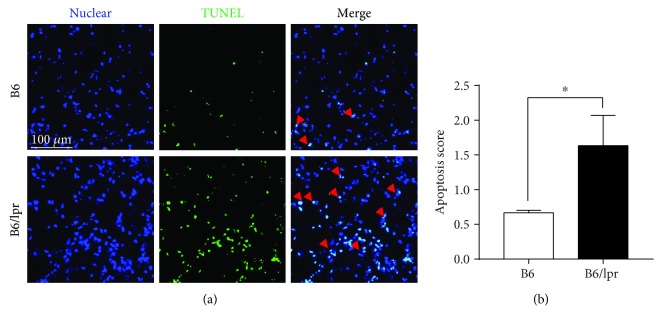
Infection induced elevated apoptosis of lung cells in the lupus-prone mice. B6 and B6/lpr mice were infected with Hi and sacrificed two days later. (a) Apoptosis of lung cells was determined by the TUNEL assay. The nuclei were counterstained with DAPI dye (blue) and TUNEL-positive nuclei (green fluorescence, indicated by red arrowheads in the merged photos). Scale bar = 100 μm. (b) Apoptosis score for the lung was calculated. Data were expressed as means ± SEM. n = 3 mice for each treatment group; ∗p < 0.05. This experiment is representative of three individual experiments.